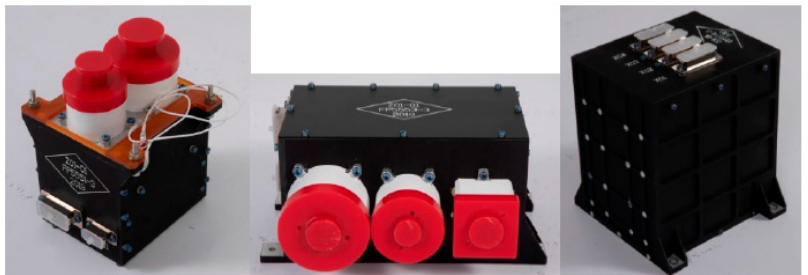
Figure 2. Photos of the high-energy particle detector (( Left panel ): − X probe; ( central panel ): +Y/Z probe; ( right panel ): electronic box).